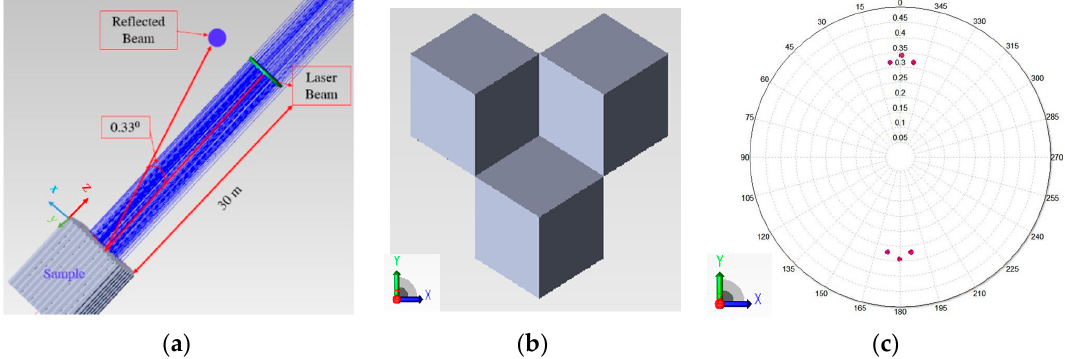
Figure 5. ( a ) Set-up for optical simulations of corner-cube retro-reflectors (CCRs); ( b ) the orientation of the corner cube; and ( c ) the retro-reflected beams intensity distribution.